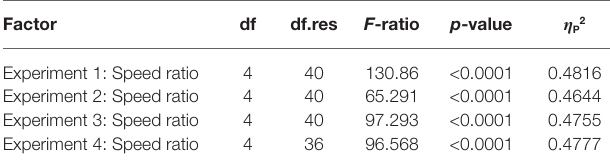
TABLE 1 | ANOVA Table for the results of Experiments